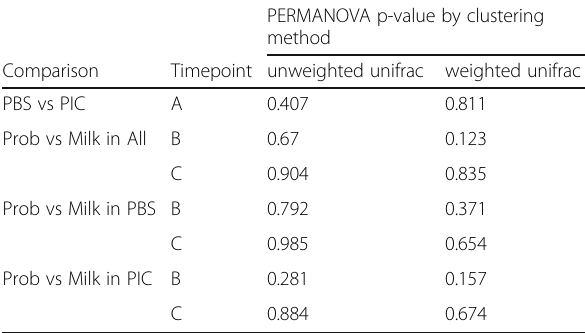
Table 4 Microbiome beta diversity